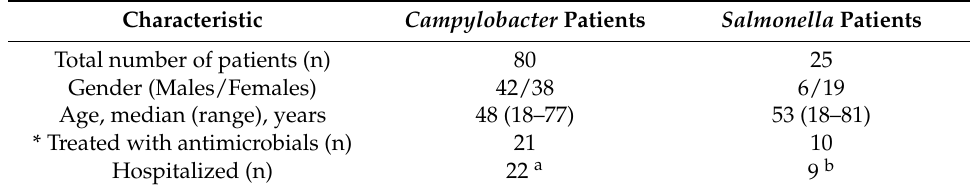
Table 1. Characteristics of Campylobacter and Salmonella patients